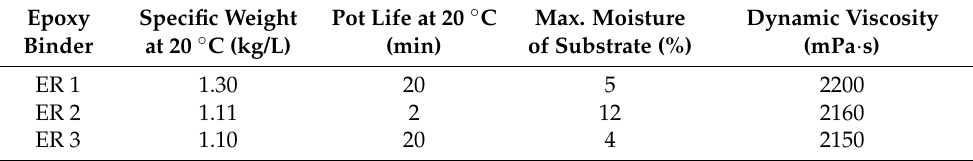
Table 2. Properties of epoxy binders used within the